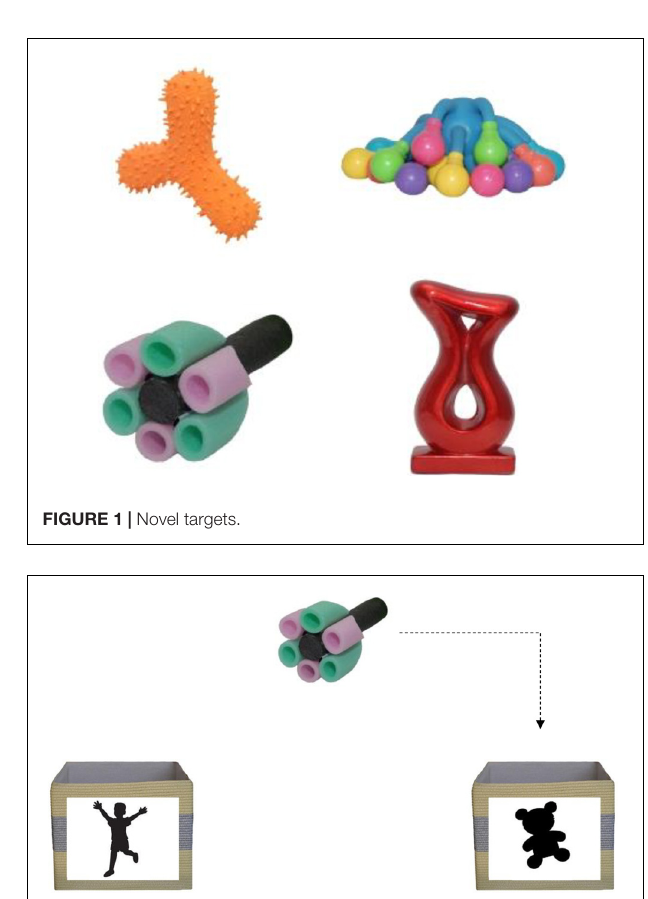
FIGURE 2 | Child/self- and teddy/other-reference